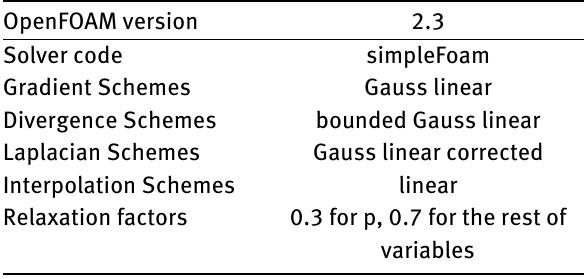
Table 1: Model implementation